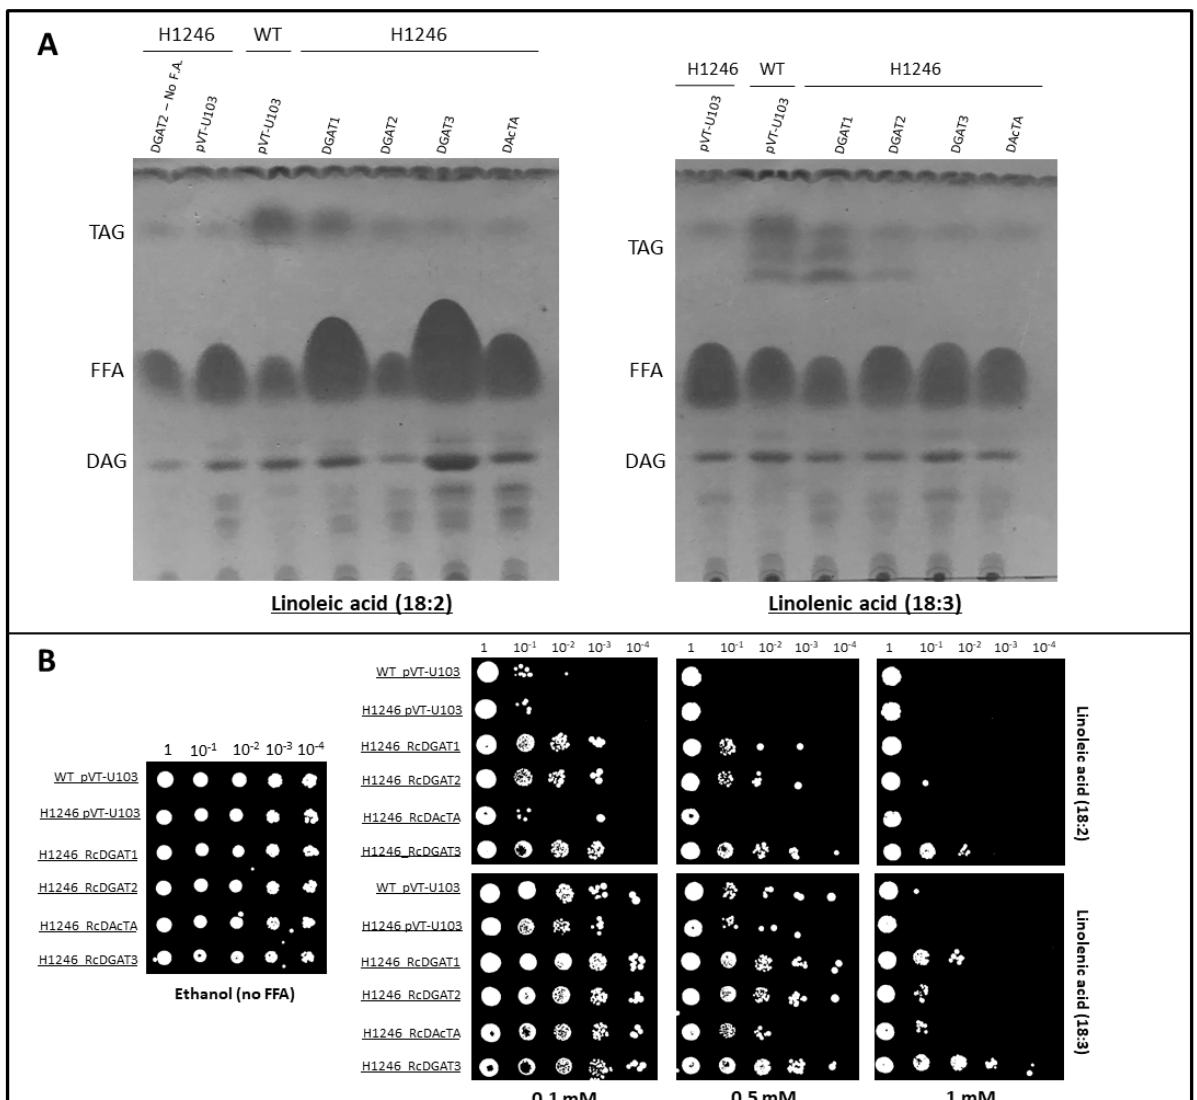
Figure 6 – Complementation assay using H1246 mutant yeast and free fatty acid (FFA) supplementation. (A) TLC from lipid extracts of WT yeast and mutant yeast (H1246) carrying the empty vector (pVT-U103), or expressing different castor bean DGATs (RcDGAT1, RcDGAT2, RcDGAT3 and RcDAcTA). Yeast were grown in the presence of 0.2 mM of linoleic acid (18:2, left panel), or linolenic acid (18:3, right panel). (B) Rescue of lipotoxicity phenotype in H1246 cells expressing RcDGAT genes. Yeast were grown for seven days in selective medium (without uracil), in the absence of FFA (left panel), in the presence of linoleic acid (18:2, right panel, first line), or linoleic acid (18:3, right panel, second line) in different concentrations (0.1, 0.5 and 1 mM). Yeast growth is displayed by applying 10 μl of each dilution (1 to 10 -4 , from left to right) of mutant (H1246) or WT yeast. TAG: Triacylglycerides; FFA: Free Fatty Acids; DAG: